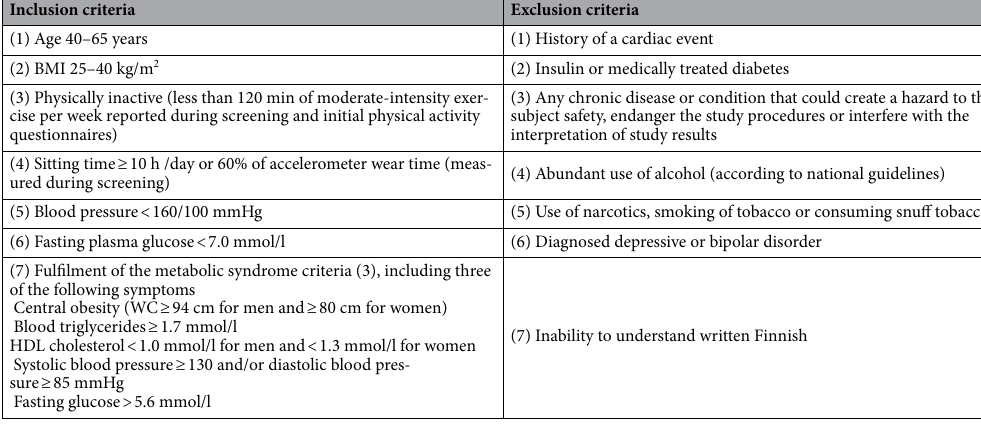
Table 1. Inclusion and exclusion